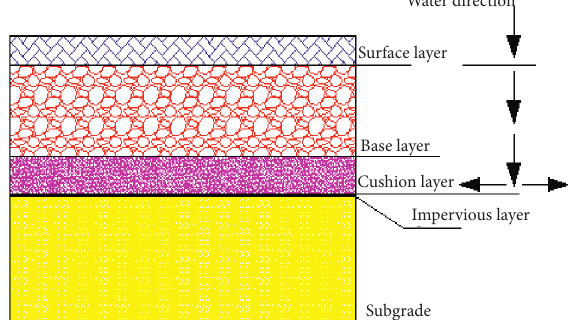
Figure 4: Semipermeable pavement structure.